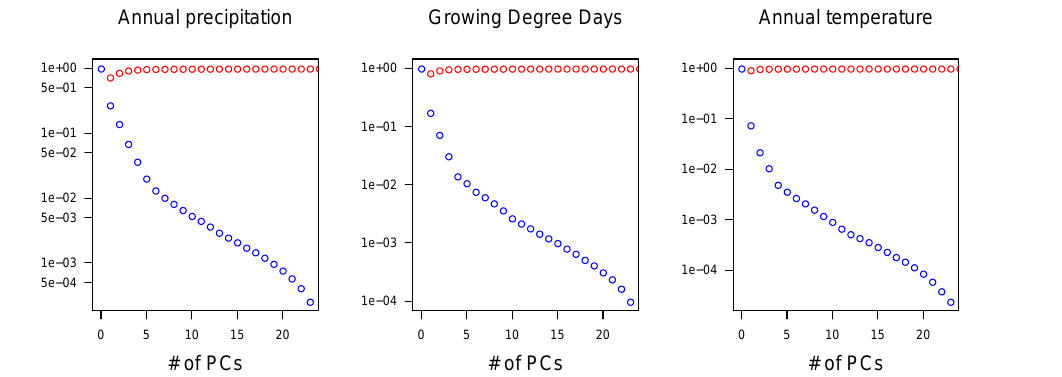
Figure 3. PCA decomposition of the logarithm of annual precipitation, GDD, and annual temperature fields based on the experiment design. Shown are the cumulated normalised variances resolved by the principal components (red) and the remaining variance (blue), which is modelled as white noise in Eq. (18), as a function of (cid:96) . Quantities are grid-cell averages.